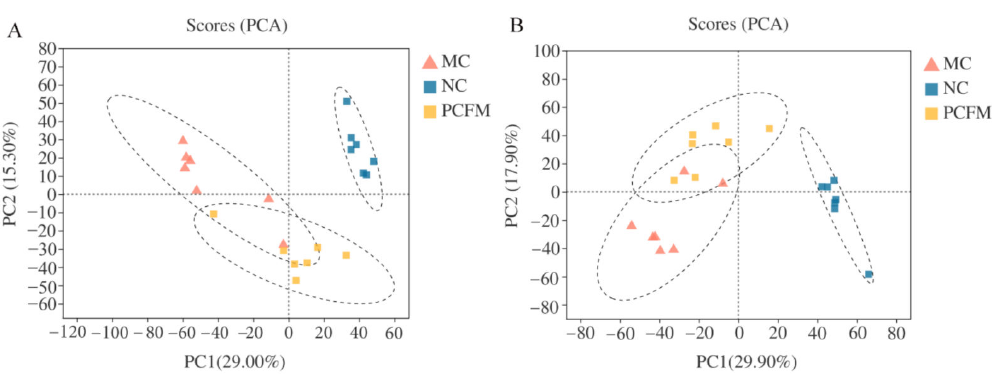
Figure 5. After 5 weeks’ treatment, e ff ects of oral prolamin from cooked foxtail millet (PCFM) on serum metabolic profile in mice. A–B: principal component analysis (PCA) score plots of serum metabolic profiles in all groups (( A ): positive ion; ( B ): negative ion) ( n = 7 mice / group). MC: model control group; NC: normal control group; PC1, PC2: principal component 1 and principal component